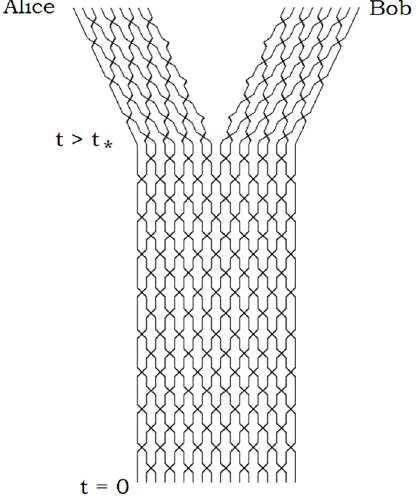
Figure 9 . A scrambled system of 2 N qubits can be separated into Alice’s and Bob’s subsystems which due to the scrambling are close to a maximally entangled state. Since they are maximally entangled, it must be possible to shorten the wormhole by restricted unitary